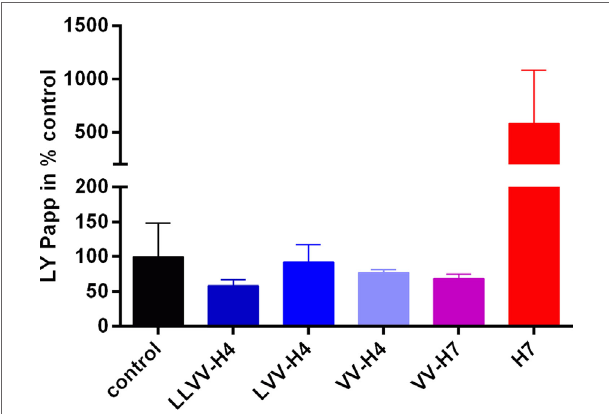
FigUre 3 | Lucifer yellow (LY) permeability across the intestinal barrier model in presence of each hemorphin. The marker of paracellular transport LY was applied together with each hemorphin on the apical side of the transwell and its passage into the basolateral chamber was monitored by spectrofluorescence. Collecting basal samples at different time points allowed calculation of the apparent permeability coefficient (Papp) of LY which, when below 1e − 006 cm s − 1 is commonly indicative of the cell barrier integrity.